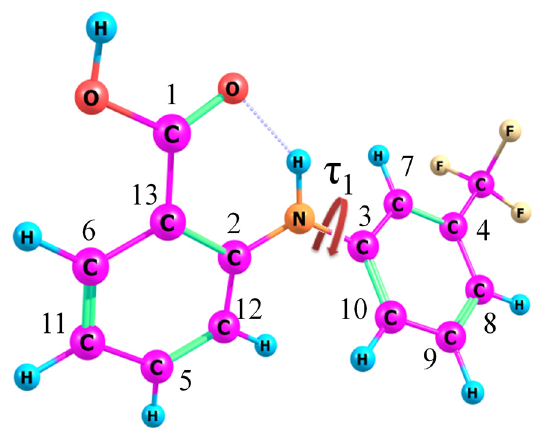
Figure 2. Structural formula of FFA. Atom numbering is used to label the signals and cross-peaks in the NMR spectra and to denote the dihedral angles. The dihedral angle τ 1 [C 2 -N-C 3 -C 7 ] is shown by the red